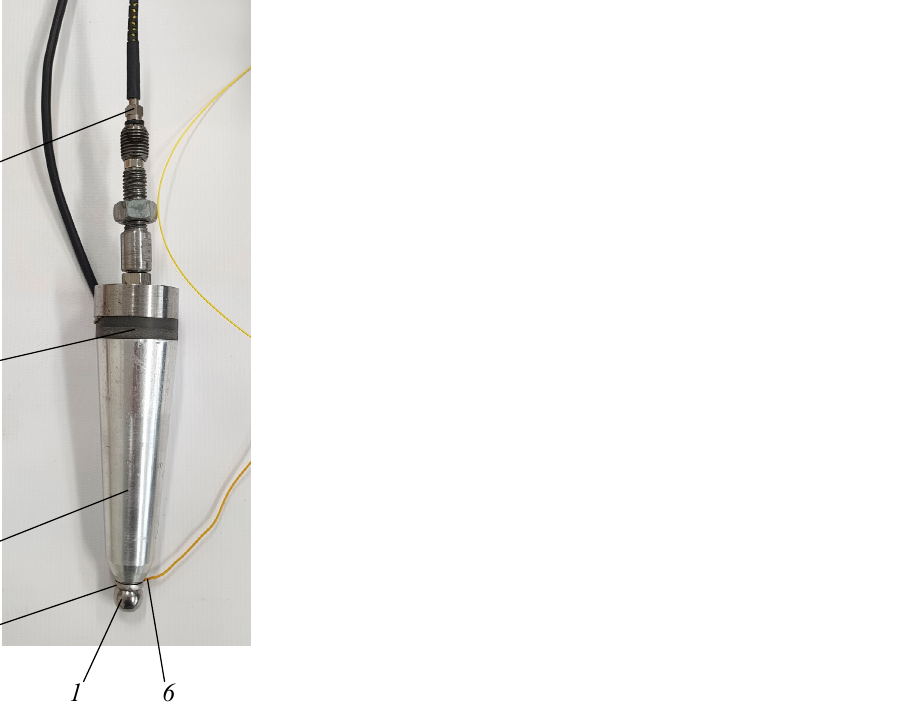
Figure 14. Polymer sheet SPIF tool: 1—metal sphere, 2—ring-shaped magnet, 3—waveguide, 4—ultrasonic vibration transducer-piezoceramic discs, 5—fiber optics, 6—temperature sensor.